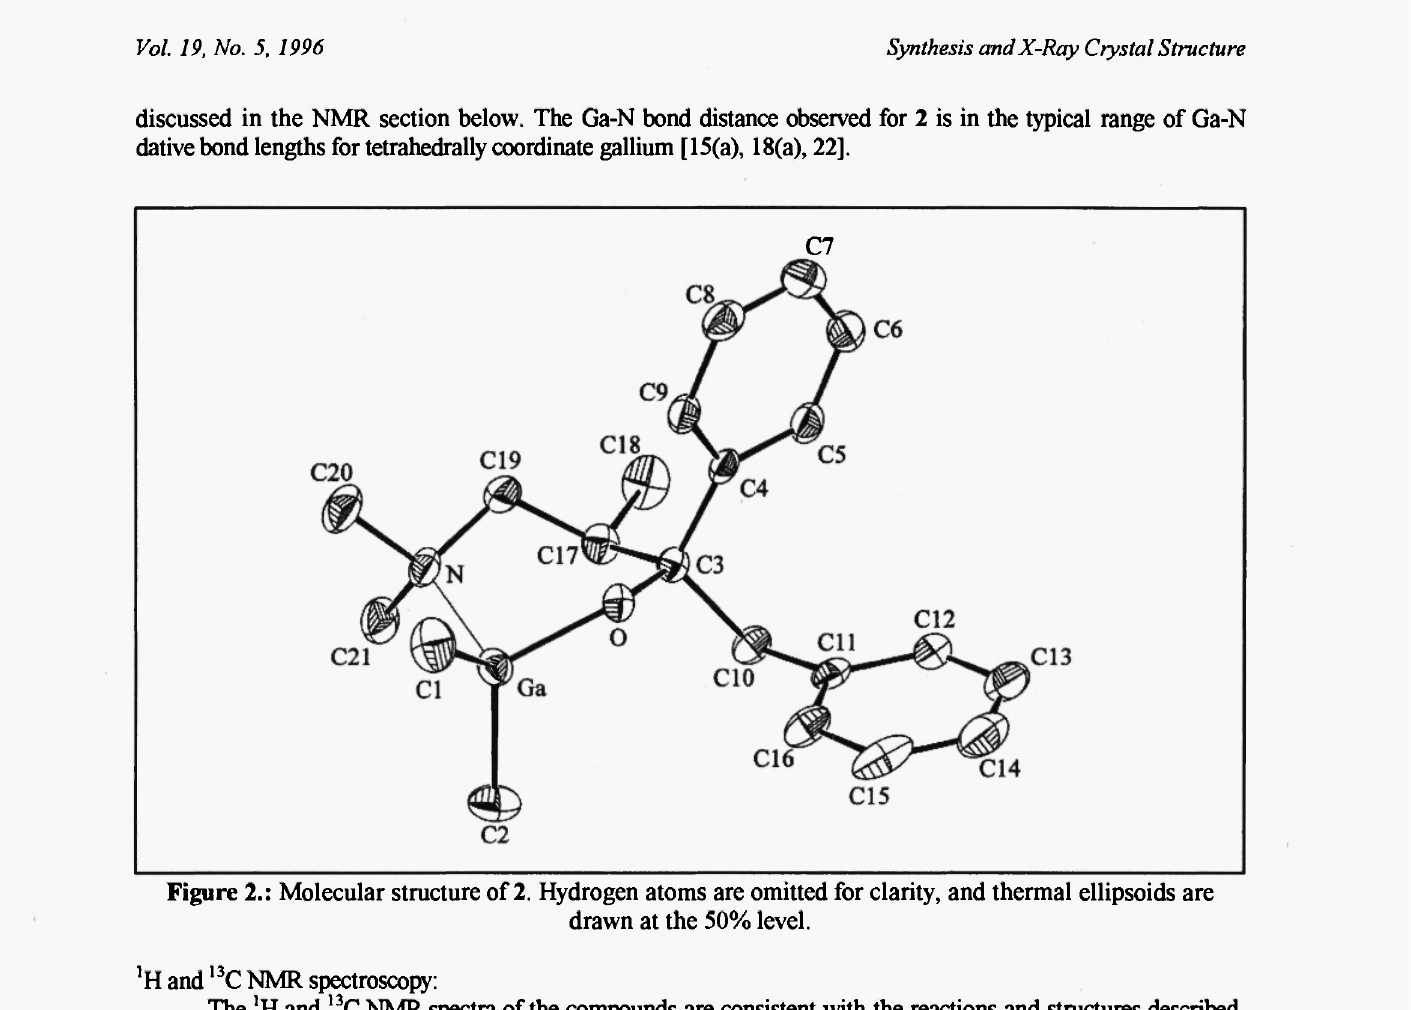
Figure 2.: Molecular structure of 2. Hydrogen atoms are omitted for clarity, and thermal ellipsoids are drawn at the 50%